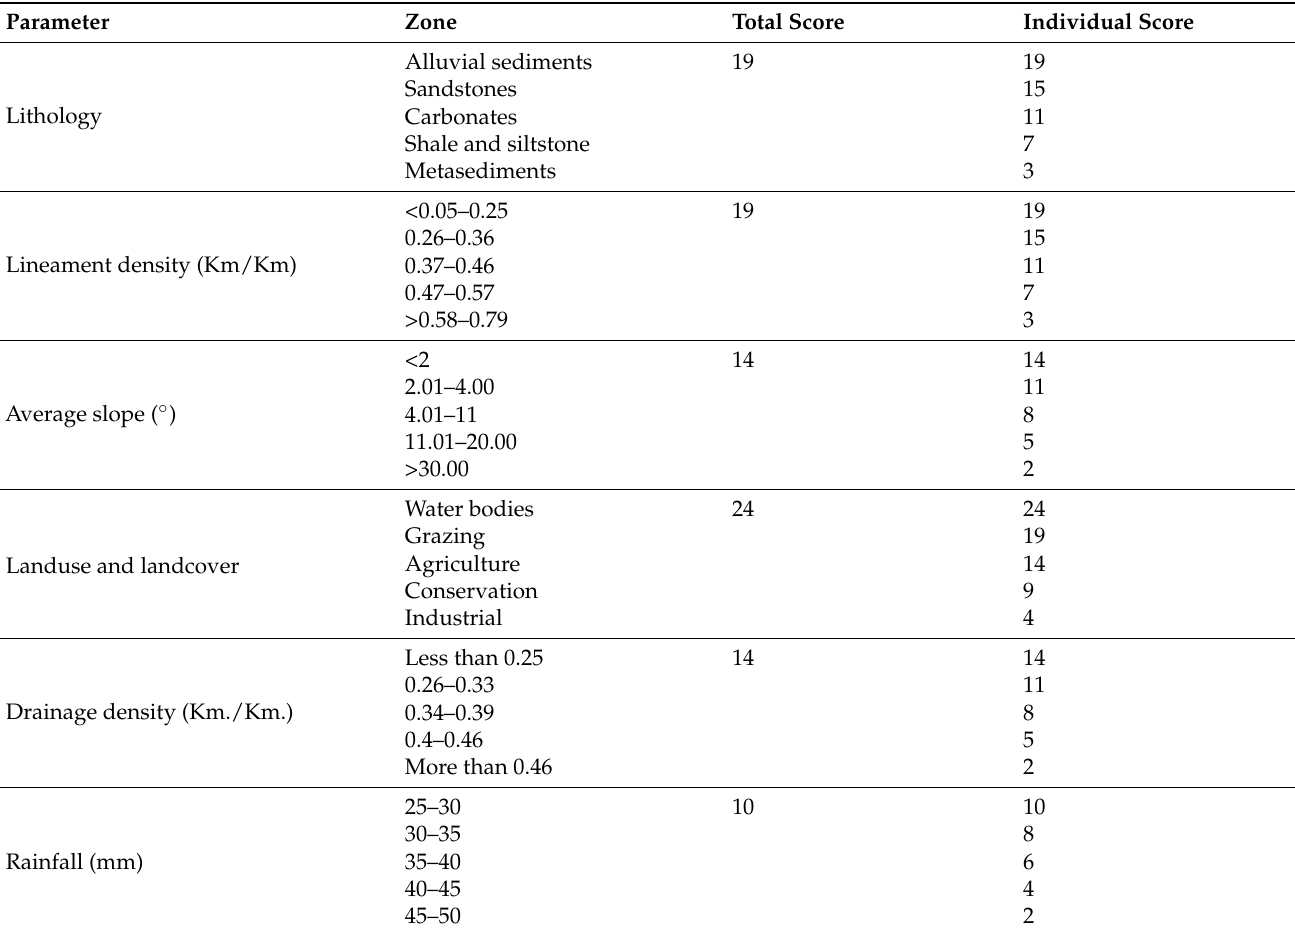
Table 3. Classification of weighted parameters influencing the groundwater potential zone (GWPZ). Parameter Zone Total Score